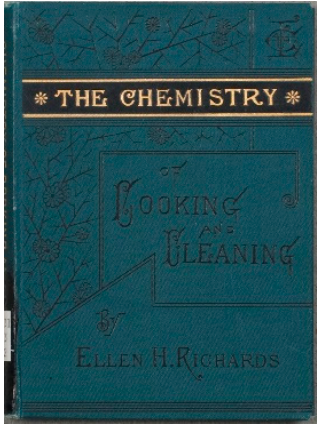
Figure 8. Richards’ The Chemistry of Cooking and